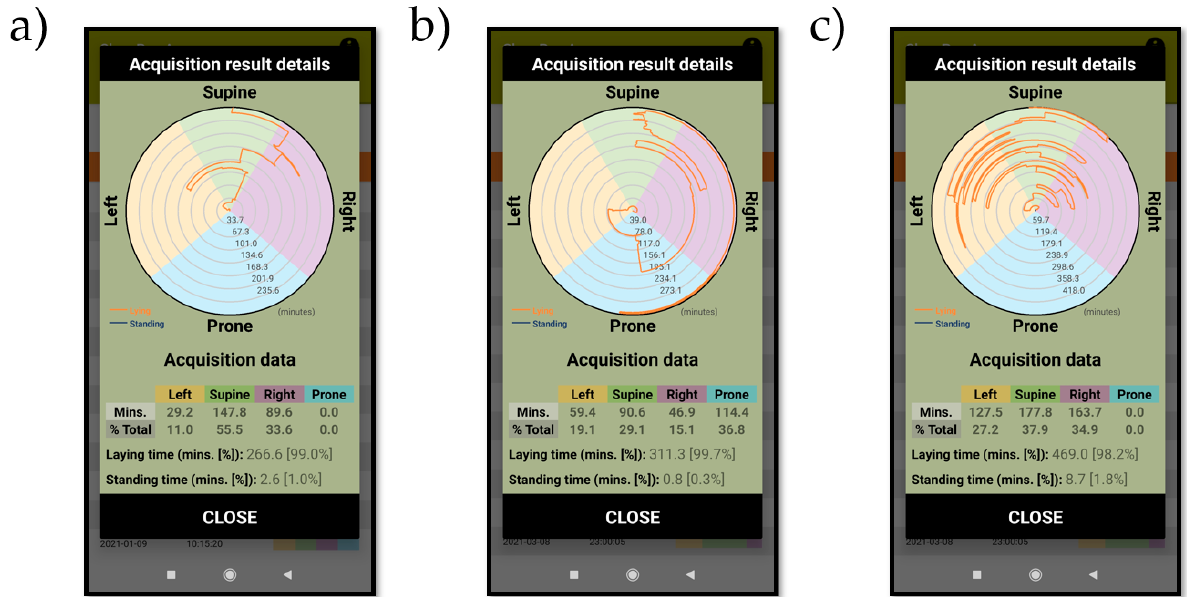
Figure 4. Screenshots of the ‘SleepPos’ app results for subject 2 ( a ), 6 ( b ) and 16 ( c ). For each subject, the angular sleep position is provided, as well as the summary of results for each sleep position. It is possible to observe how subject 2 ( a ) and 6 ( b ) have few position changes, whereas the subject 16 ( c ) has a lot of position changes. This behavior is only noticeable on the angular-based high-resolution sleep position as it is not possible to be seen in the summary table.